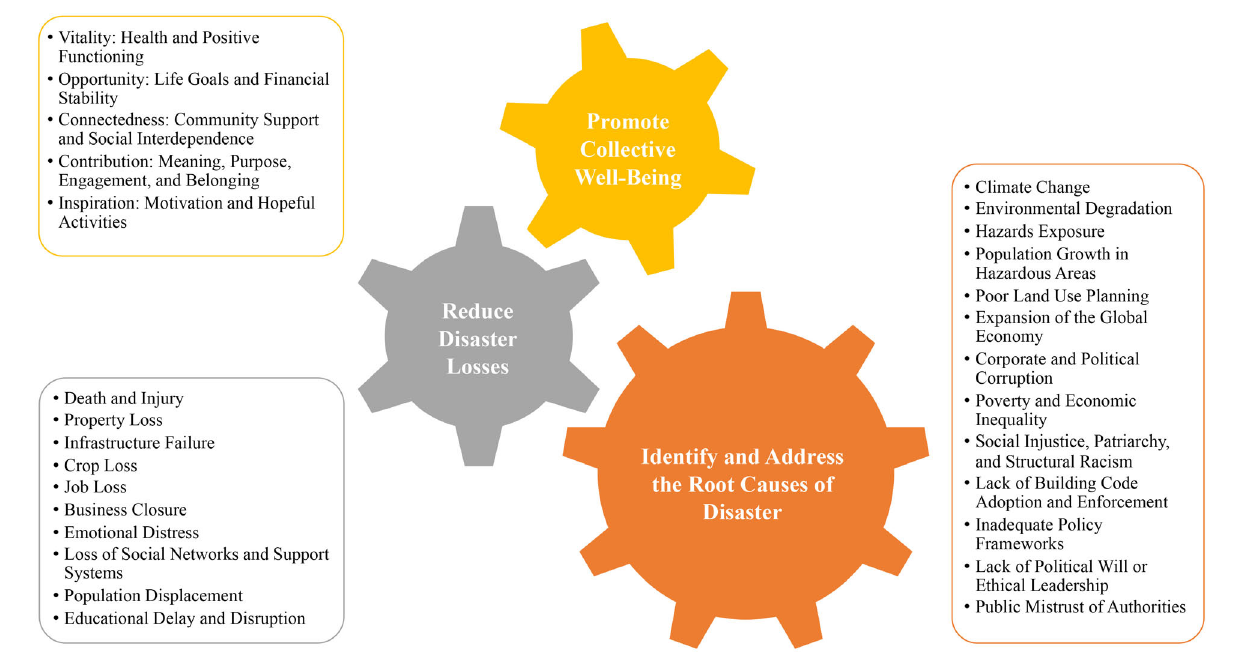
FIGURE 6 | Goals for convergence research in the hazards and disaster field.